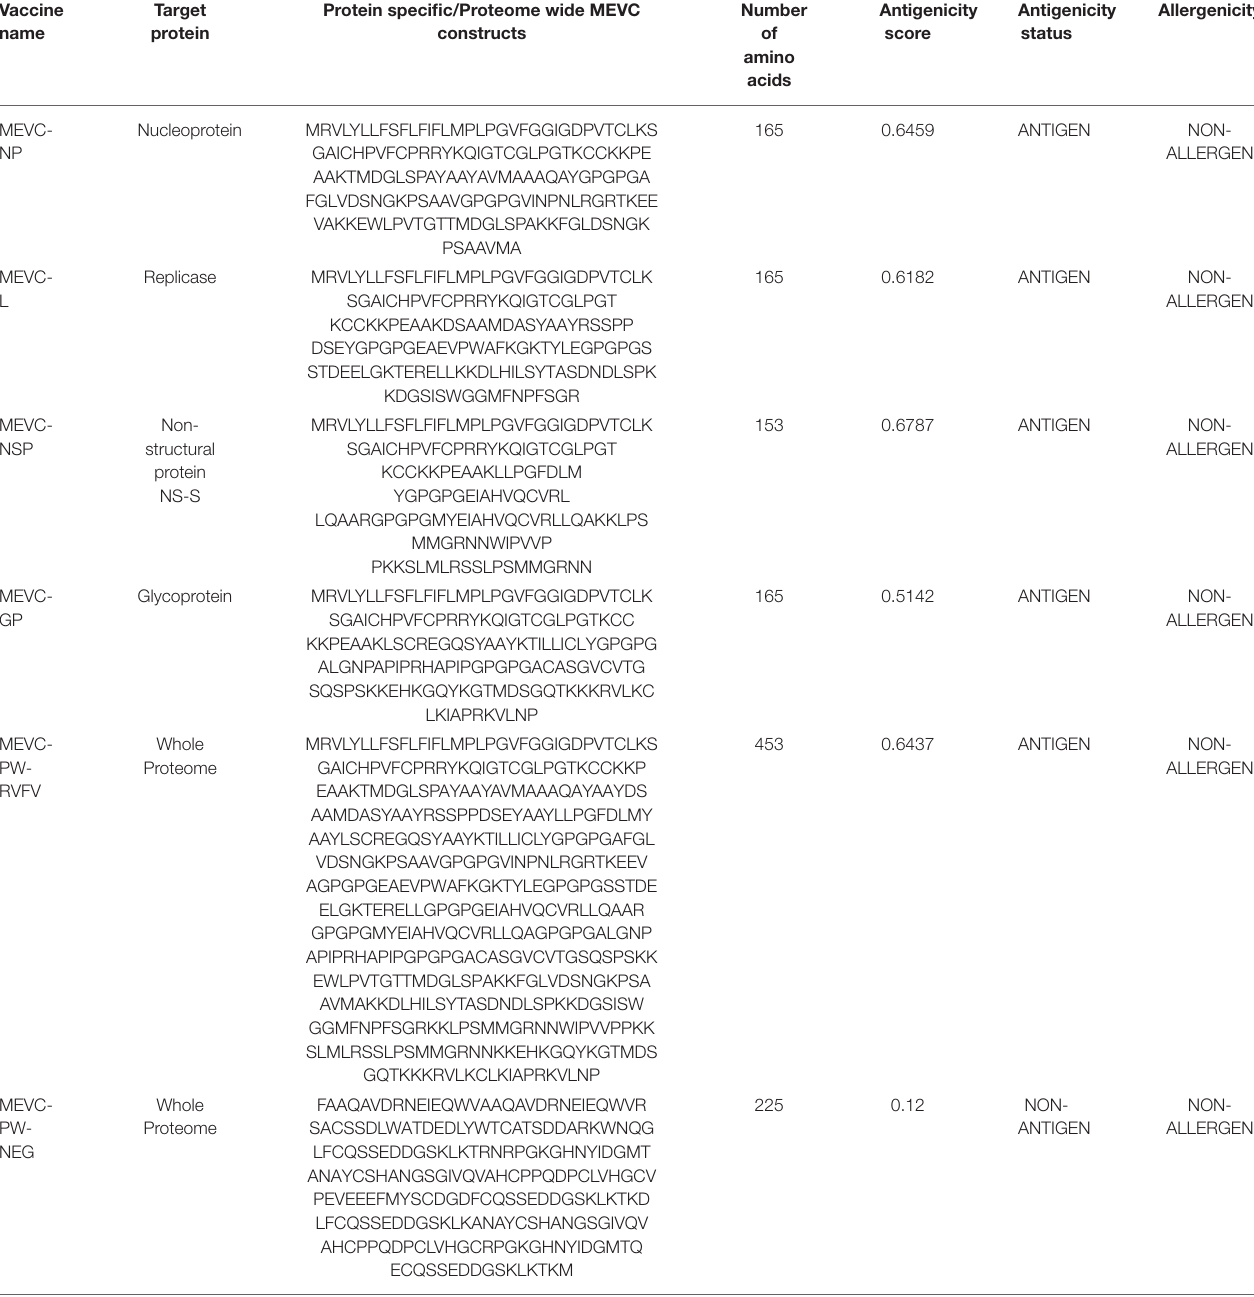
TABLE 6 | Details of the final vaccine constructs and their immunogenic potential designed against each target protein of